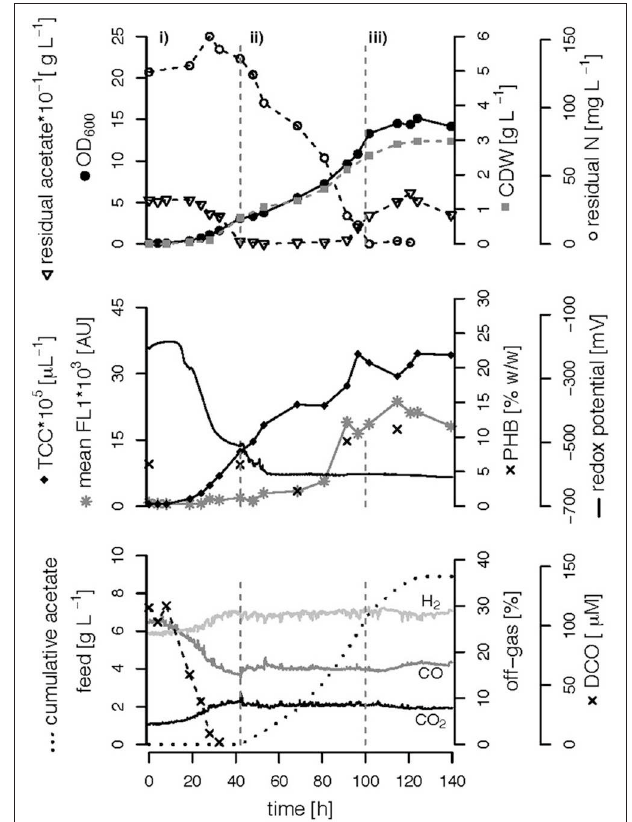
FIGURE 4 | C,N-limited fed-batch fermentation. R. rubrum was grown on modified RRNCO medium with a reduced ammonium content and continuous syngas supply. The process is separated into three phases by gray dashed lines: (i) batch phase during which the initial acetate is consumed, (ii) acetate fed-batch, (iii) acetate fed-batch phase with C and N limitation. All abbreviations are the same as in Figure 3